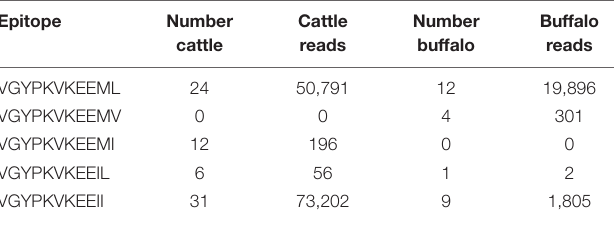
TABLE 4 | Tp1 epitope variants found in cattle and buffalo